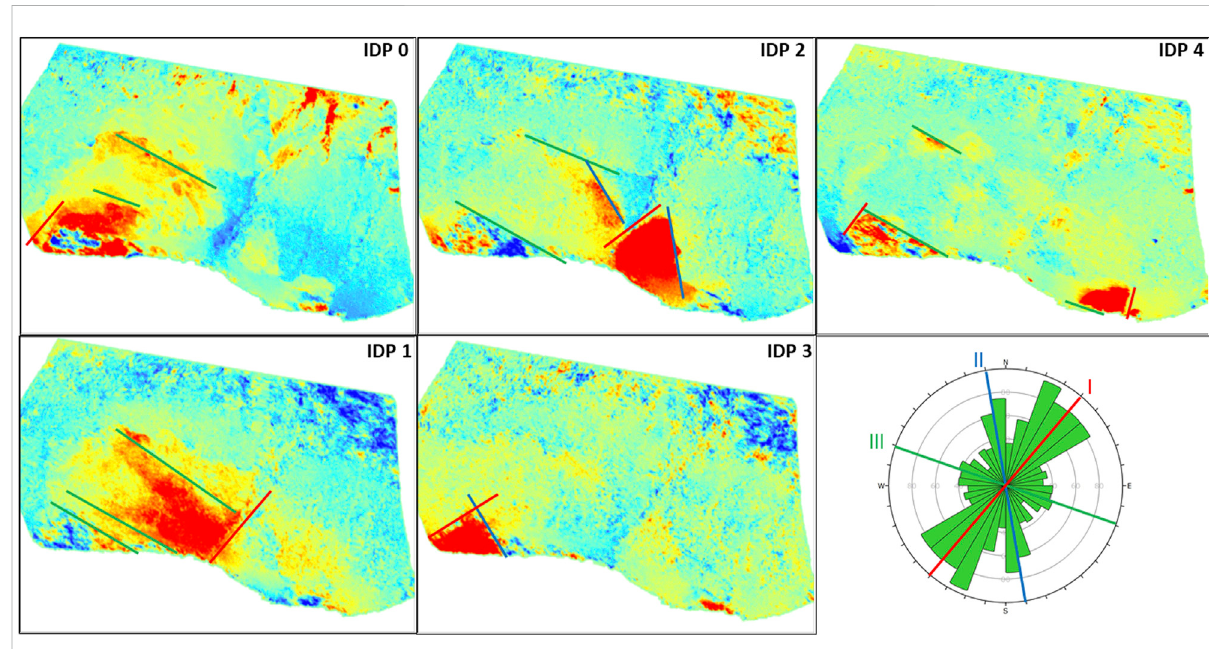
FIGURE 11 Prominent lineaments overlain on the IDP maps and colour-coded on the basis of orientation. Note the similarity between the IDPs and the major lineament trends. The rosette plot displays the trends of the mapped lineaments as identi fi ed by Donati et al.